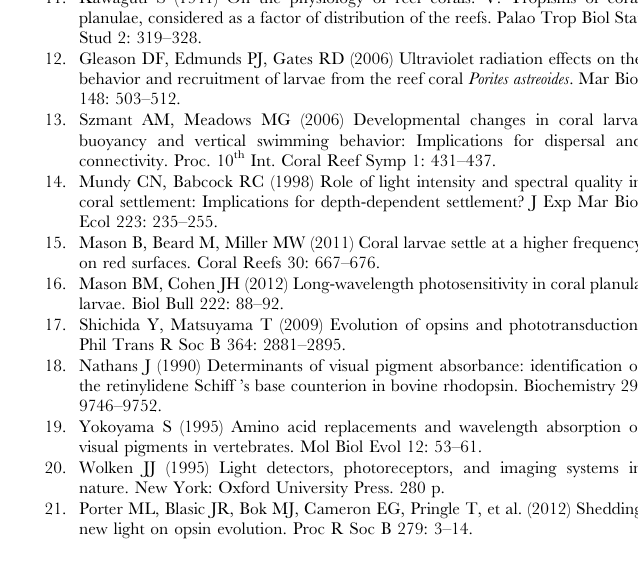
Figure S1 Opsin family tree. Phylogenetic tree consisting of fifty-six amino acid sequences representing eight opsin families.